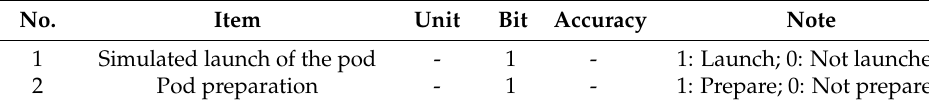
Table 2. Instructions of the carrier.